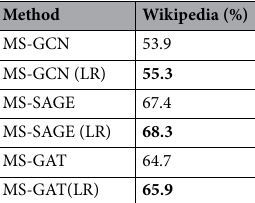
Table 6. Summary of the effect of LR motif on classification accuracies. Significant values are in bold.